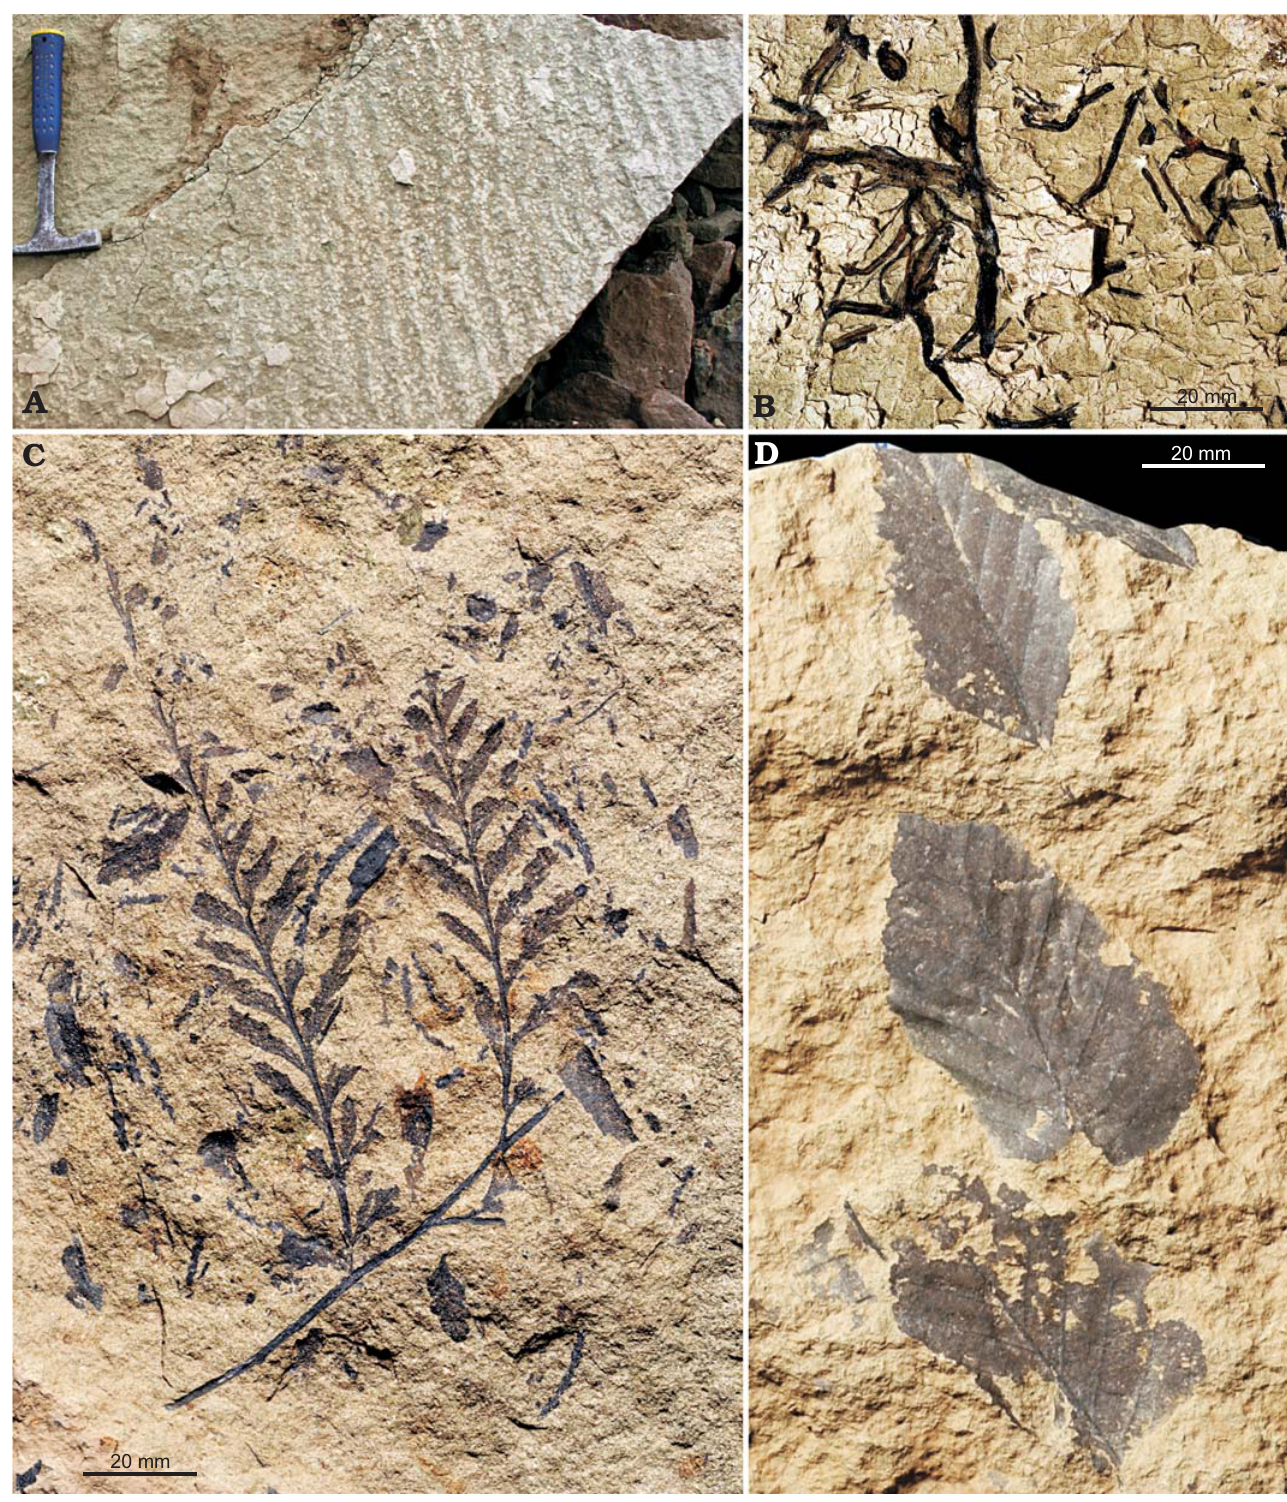
Fig. 3. Some sedimentary and palaeobotanical features of the middle–late Eocene, Mount Wawel Formation, Martel Inlet Admiralty Bay, King George Island, Antarctica. A . Symmetric ripple marks on surface of very fine-grained sandstone. B . Fossil plant remains of unknown affinity in cracked mudstone. C . Delicate ferns on a parting surfaces. D . Leaves of Nothofagus